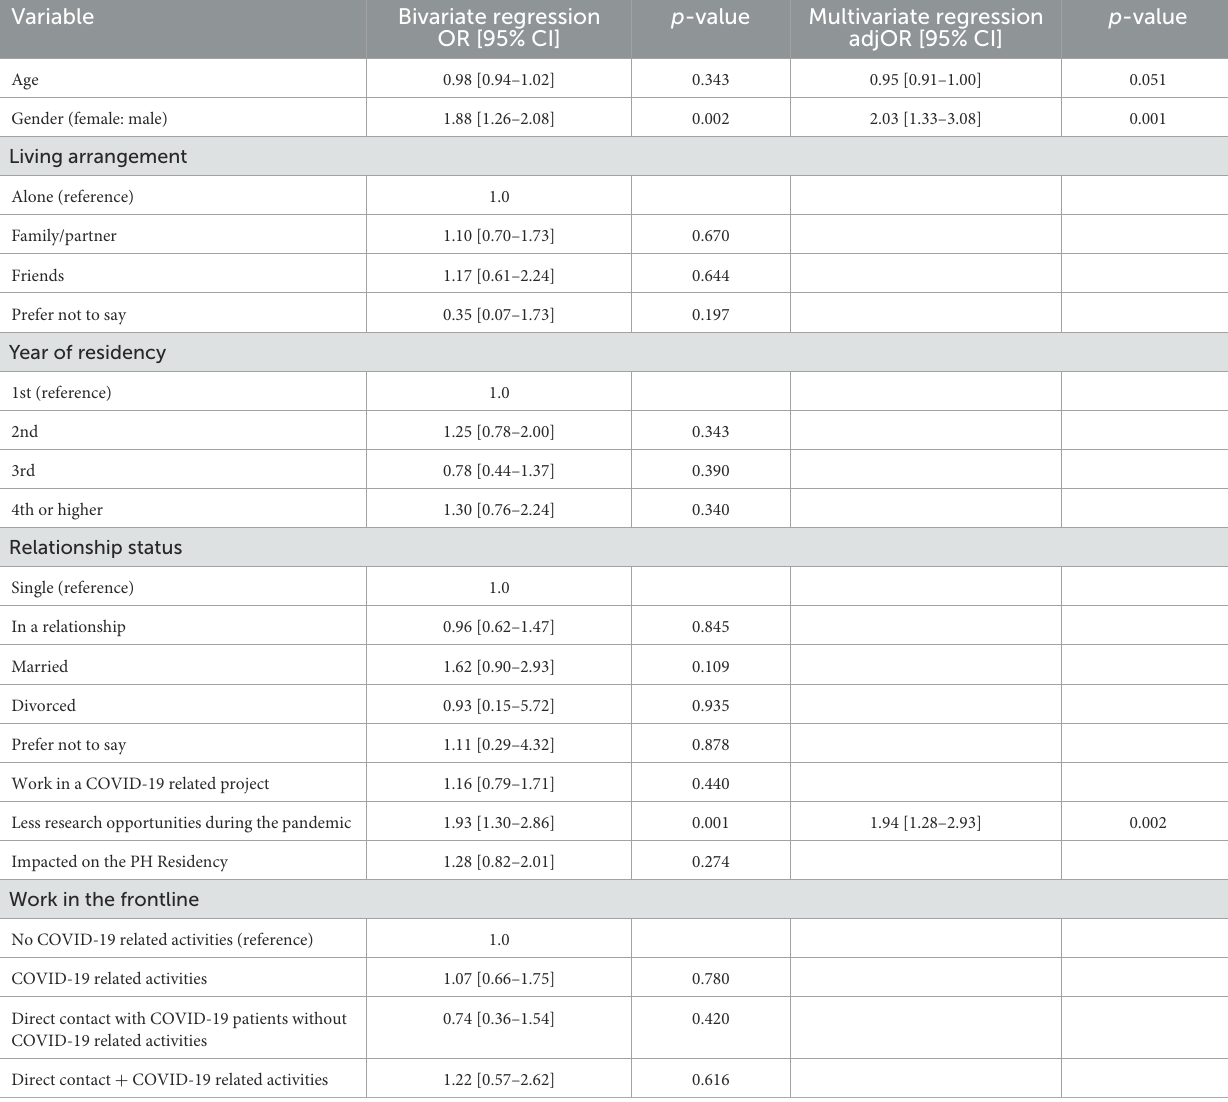
TABLE 4 Factors associated with anxiety, resulting from the univariate and multivariate regression analysis of the data (Public Health Residents’ Mental Health, Europe, 2021–2022).